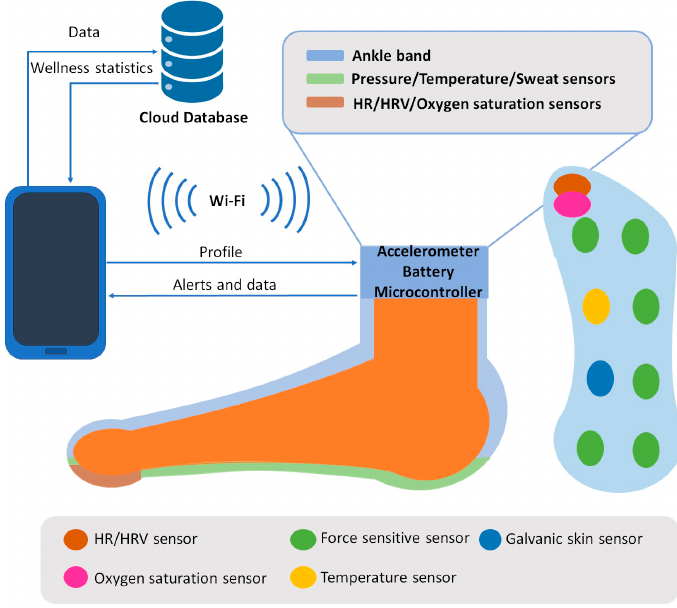
Figure 1. Architecture of the proposed system.